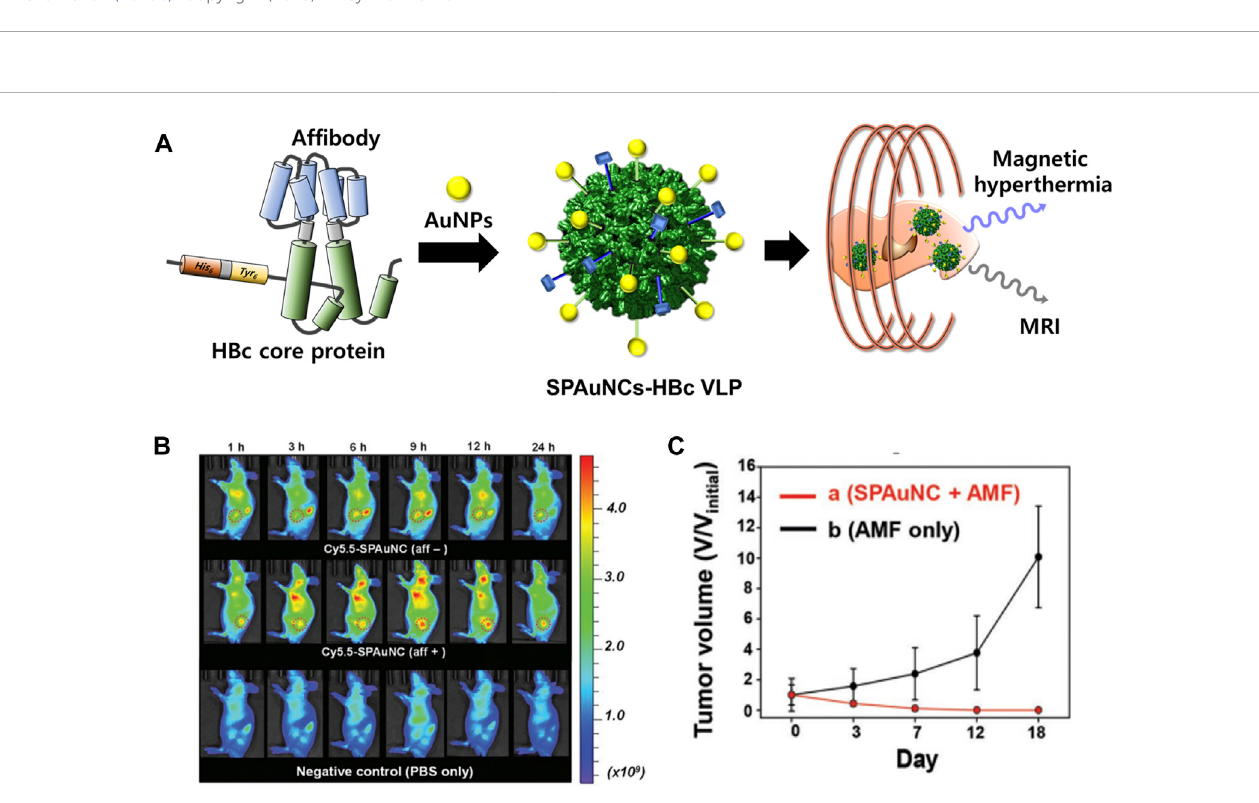
FIGURE 9 (A) Schematicillustration ofthepreparationofSPAuNCsforcancertheragnosis. (B) NIR fl uorescenceimagesofmicebearingasubcutaneousMDA-MB- 468 tumor after the intravenous injection of SPAuNCs. (C) Cancer treatment ef fi ciency of SPAuNCs. Reprinted with permission from Kwon et al. (2017). Copyright (2017) Wiley-VCH